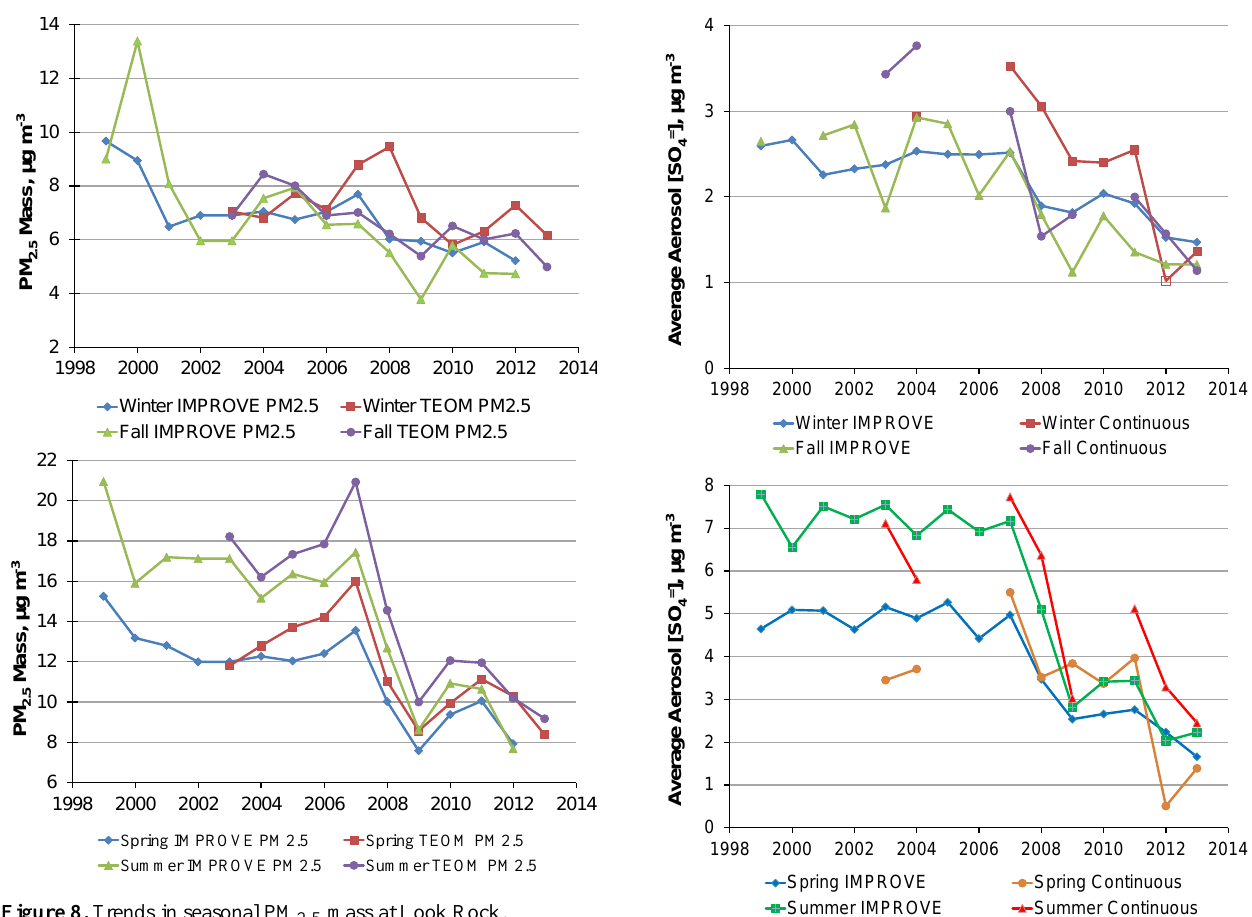
Figure 8. Trends in seasonal PM 2 . 5 mass at Look Rock.